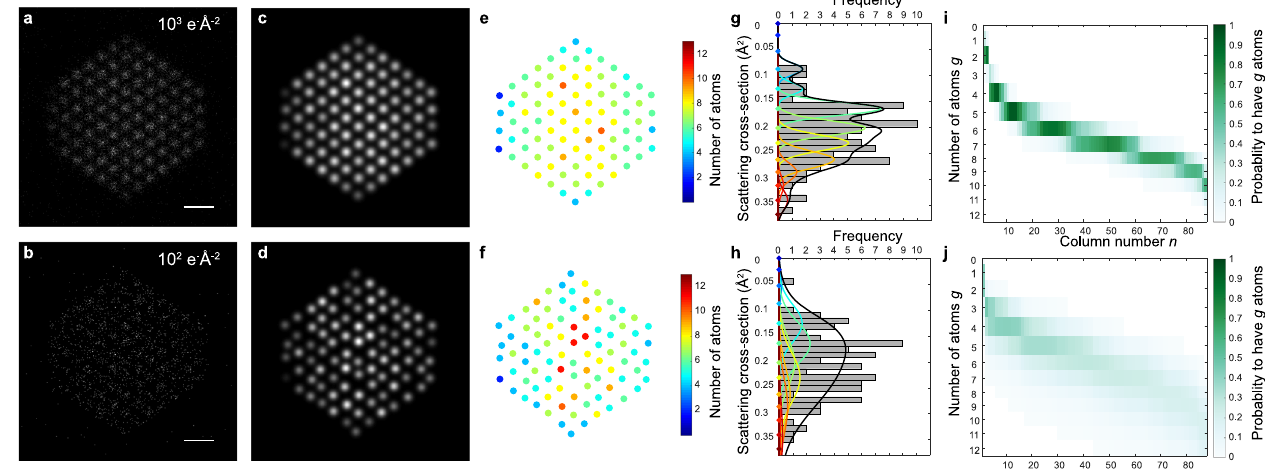
Fig. 2 Statistical atom-counting analysis and construction of the probability matrix. a , b Simulated ADF STEM images of the Pt nanoparticle embedded in the carbon support along the [110] zone axis for an incident electron dose of 10 3 and 10 2 e − Å − 2 . c , d Re fi ned parametric models of the images shown in a, b. e , f Estimated number of atoms in each atomic column for the images shown in a, b. g , h Histograms of SCSs for the images shown in a, b. The decomposition into overlapping Gaussian components is shown in color, corresponding to the number of atoms. The black curve shows the estimated mixture model. i , j Probability matrices indicating the probability for a column n to contain a speci fi c number of atoms g . The scale bars in a and b are 5 Å